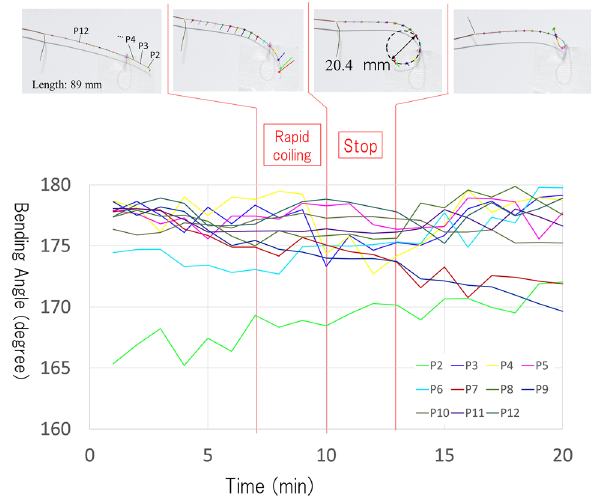
Figure 5. 3D motion tracking of the tendril coiling on thin support. Tendril of 89 mm length was placed in contact with 1 mm diameter rod. The vertical axis of the graph is the bending angle at each marked position. After the region where the angle changes rapidly (transform stage), the region with almost no change (stop stage) appears. The representative shape in each stage is shown in the upper figures. The coiling diameter in stop stage that was calculated from the 3D coordinates of the markers was about 20.4 mm.